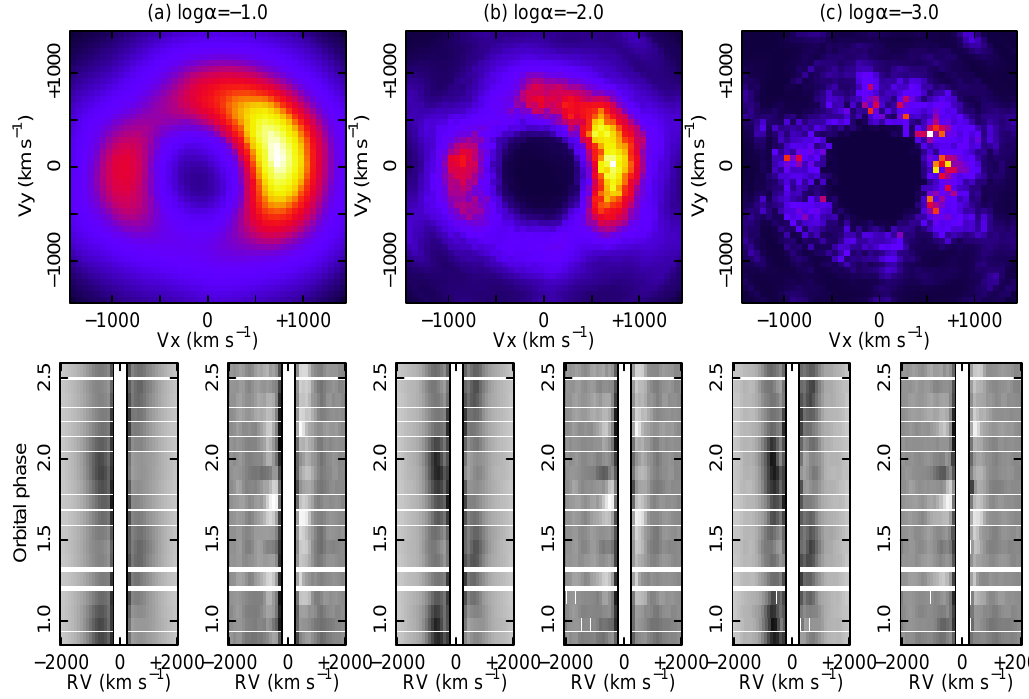
Figure 3: As in figure 2, but for the MEM